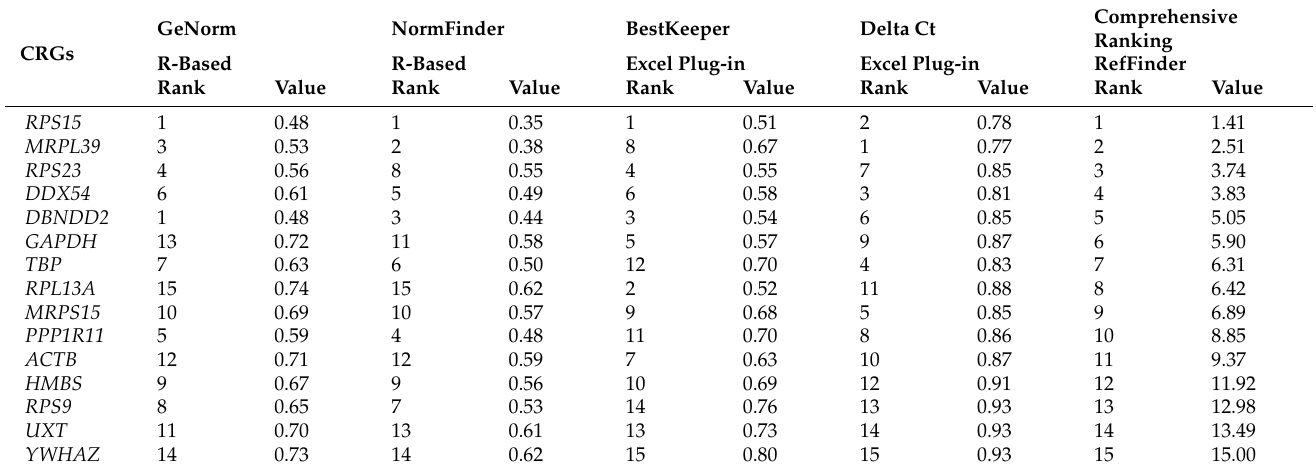
Table 2. Stability of CRGs in yak stomach throughout the growth